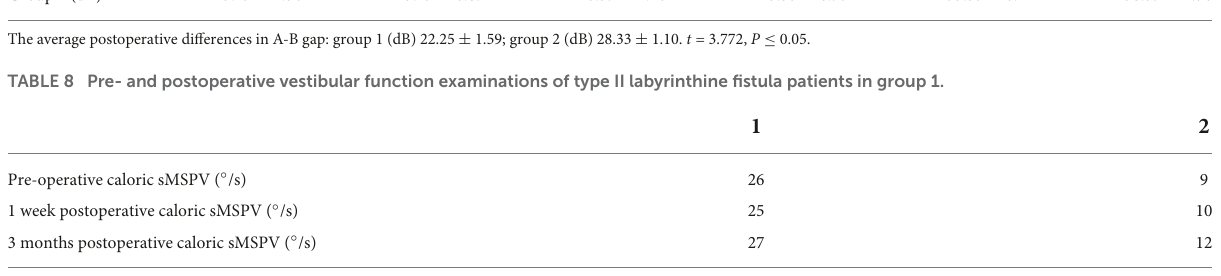
vestibular function examination (caloric test) revealed weakened vestibular function of the affected side and horizontal semicircular canal paresis, caloric sMSPV ( ◦